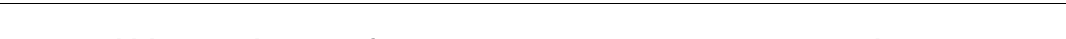
Table 5. Sensitivity Analysis Results for One-Way and Two-Way Break-Even Travel Distance Thresholds Conventional Shipping Points Break-Even Mileage/Kilometer